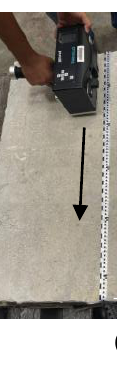
Figure 7. PAU test setup: ( a ) Line scan, ( b ) Stripe scan. Two different PAU systems were used in this experiment to determine their FRP bar detection capability, as shown in Table 4 and Figure 8. The MIRA 3D device had 64 ultrasonic transducers located in a 16 × 4 grid at 3 cm spacing (extended 16 rows of 4 transducers each) where the Pundit Live Array Pro had 24 ultrasonic transducers located in an 8 × 3 grid at 3 cm spacing (8 rows of 3 transducers each). Table 4. Technical specifications of the PAU systems used [113–115].